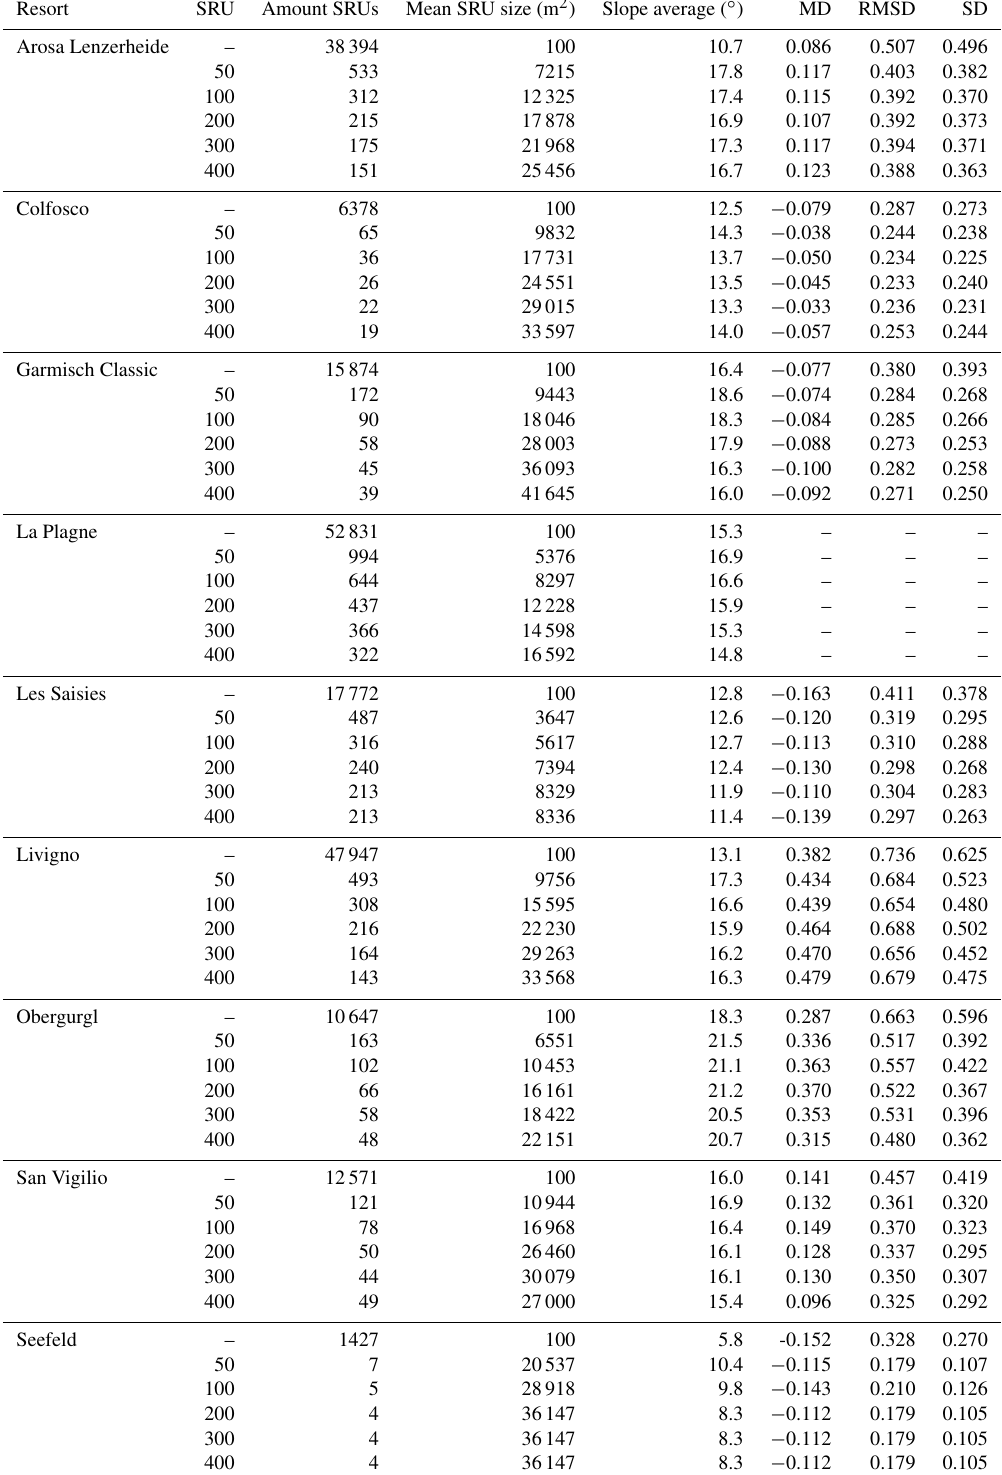
Table A2. Effect of discretization of the simulated results (10m × 10m) into different SRU elevation bands: 50, 100, 200, 300, and 400m. The first line indicates the number of 10m × 10m raster points for each ski resort. The calculated root mean square error (RMSD), mean deviation (MD), and the standard deviation (SD) are between the GNSS-measured and simulated snow depth. GNSS data were not available for La